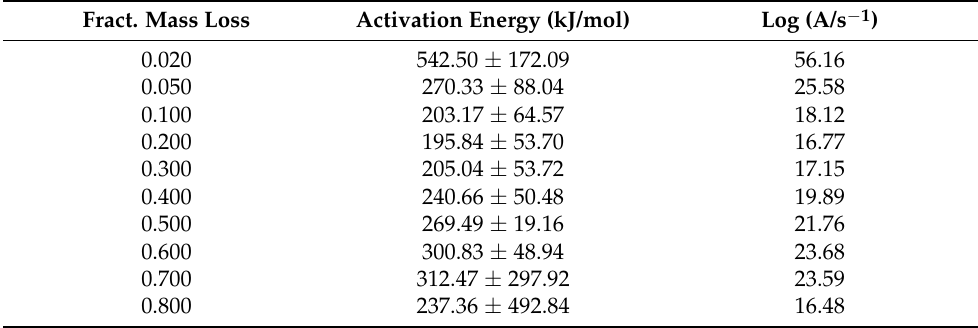
Table 2. Activation energy and pre-exponential coefficient as a function of the degree of reaction determined by the Ozawa–Flynn–Wall method for sewage